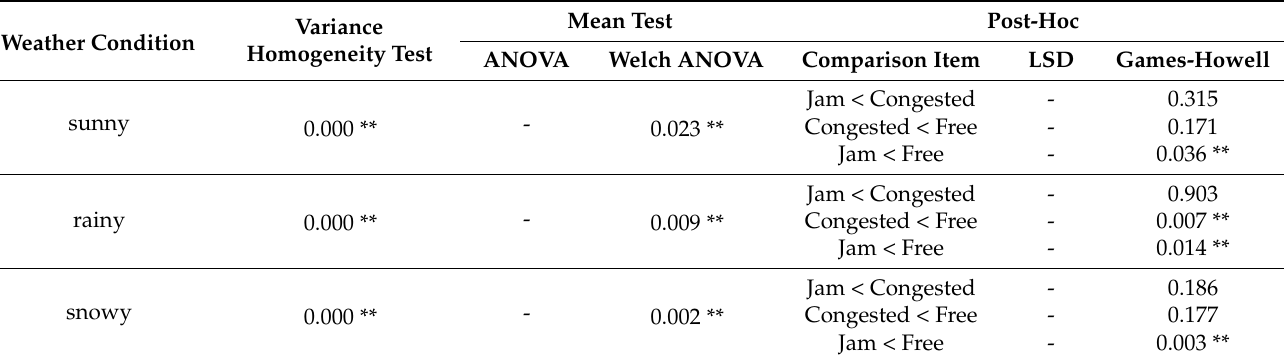
Table 6. Significance test for the standard deviation of distance headways under different traffic flow conditions.